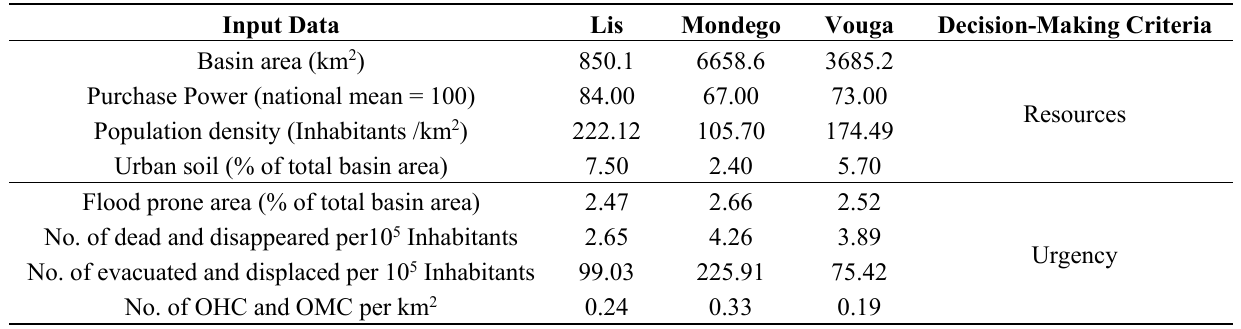
Table 3. Input data and respective decision-making criteria used in the